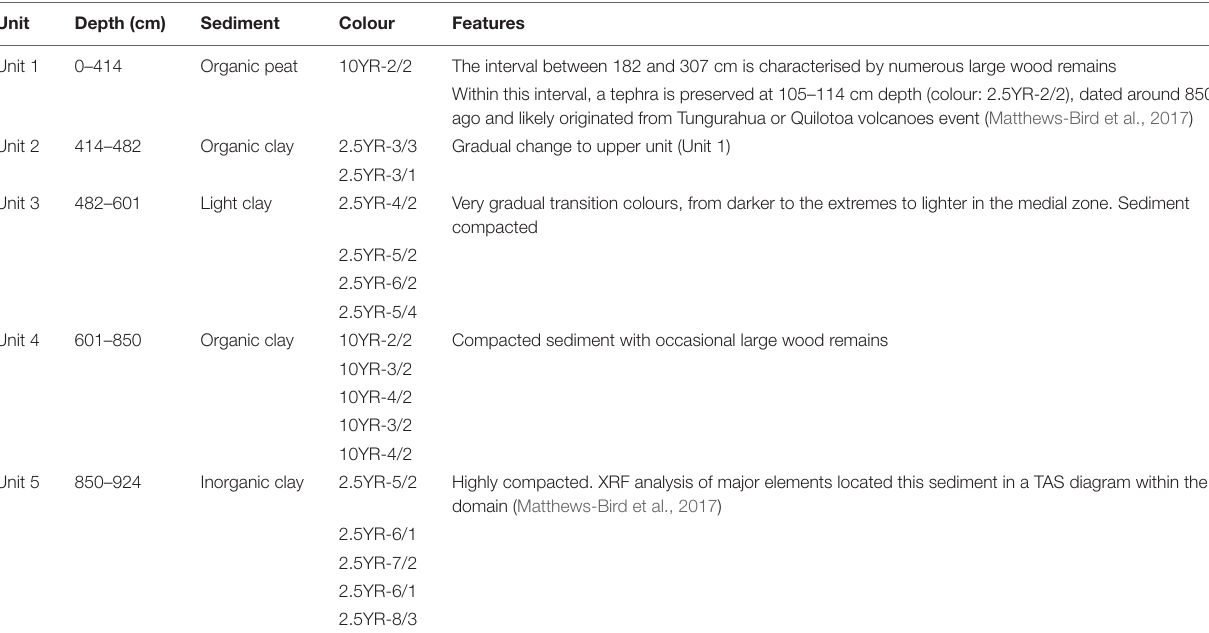
TABLE 3 | Sedimentary units defined for Laguna Pindo core including main features.